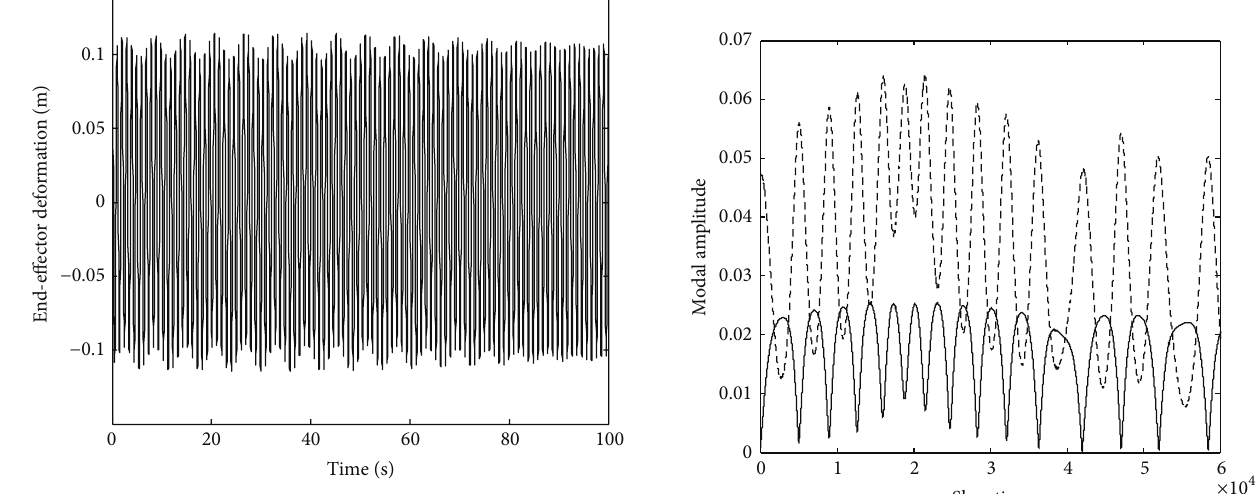
Figure 9: Response of the uncontrolled moving flexible arm in ADAMS.